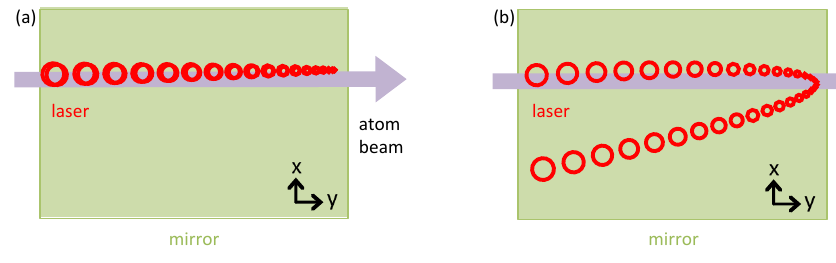
Figure 6. Top view of the multi-pass cavity with a schematic representation of the atom beams ( purple ) and the laser spots ( red ). Different alignments can result in different Doppler shifts and irradiance gradients for the laser beams that illuminate the atom beam. ( a ) The mirror angles are adjusted so the laser spots propagating in − ˆ y overlap with those propagating in + ˆ y . This configuration is used for tune-out wavelength measurements; ( b ) The mirror angles are adjusted such that the laser spots propagating in − ˆ y and + ˆ y do not